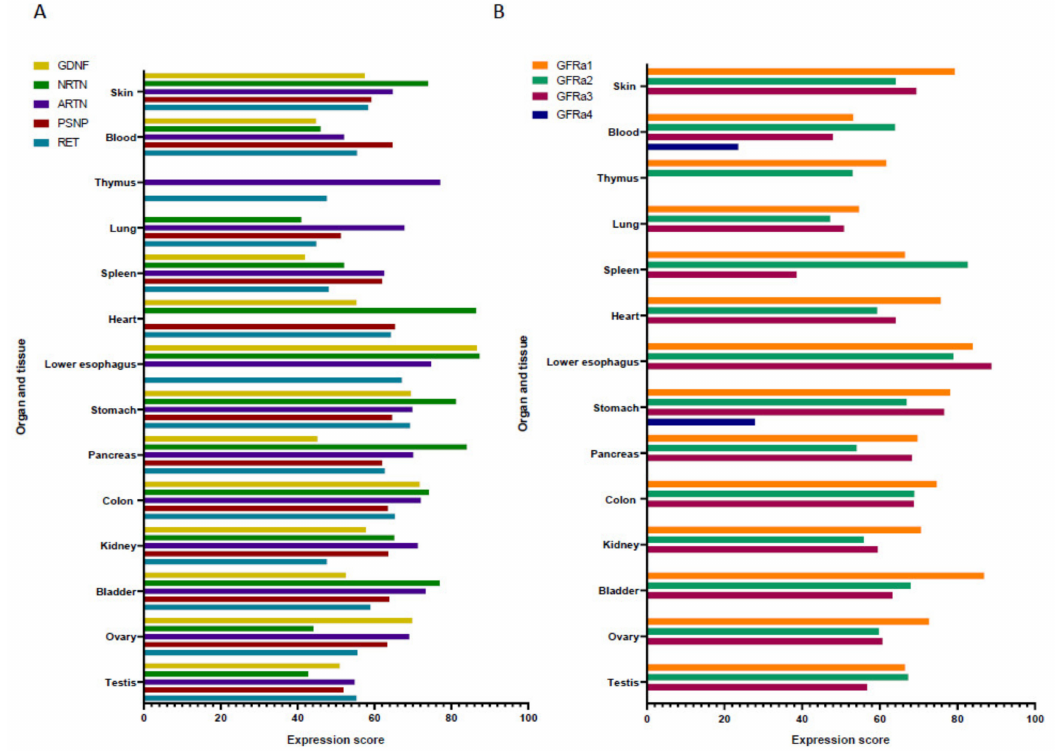
Figure 1. Expression score of the GDNF family ligands (GFLs) and their receptors in a non-exhaustive list of organs and tissues. Data of GFLs ( A ) and their receptors ( B ) are from the Bgee database (https: // bgee.org / ). They have been obtained by RNAseq and a ffi metrix microarray from 1673 healthy donors in total, aged between 45 and 65 years old. The expression score from adult healthy donors has been normalized to a value between 0 and 100 from rank scores. (Bgee version